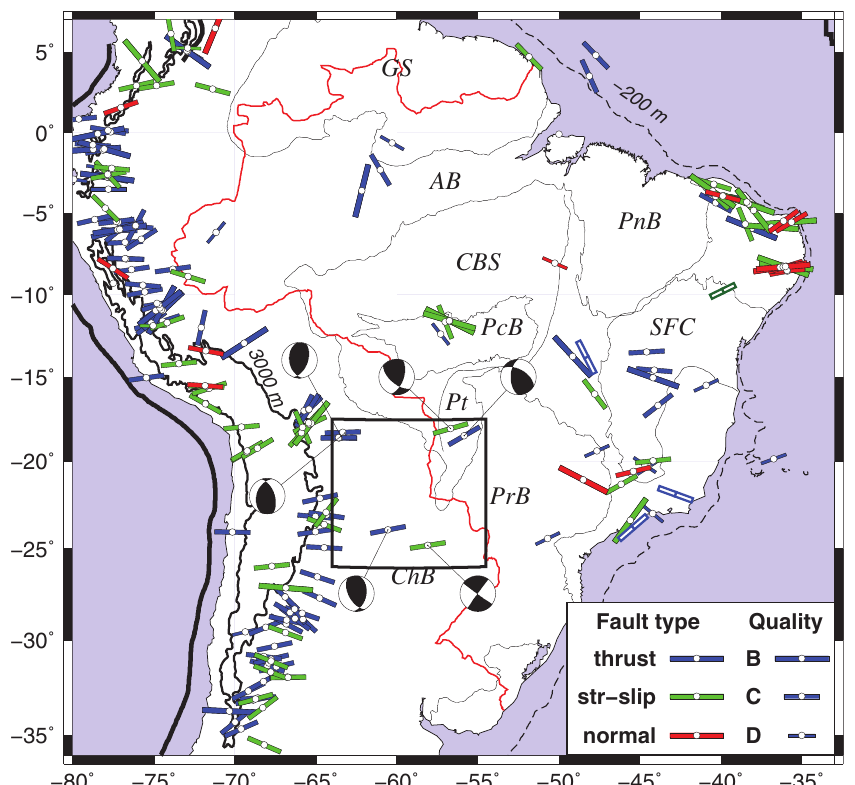
Figure 7 - Maximum horizontal stress direction from focal mechanism. The colors are the mechanism type and the size of bars (B, C and D) indicates the quality of the fault plane solution conform WSM – Project criteria (site: http://dc-app3-14.gfz-potsdam.de/index.html). The bar direction corresponds to compressional axis (P-axis) in thrust and strike-slip and null axis (B-axis, the intersection of the two nodal planes) in normal faults. The rectangle shows the mechanisms used in the stress inversion in Fig. 8. The main geological provinces are the same as Fig. 1. Data from Assumpção et al.